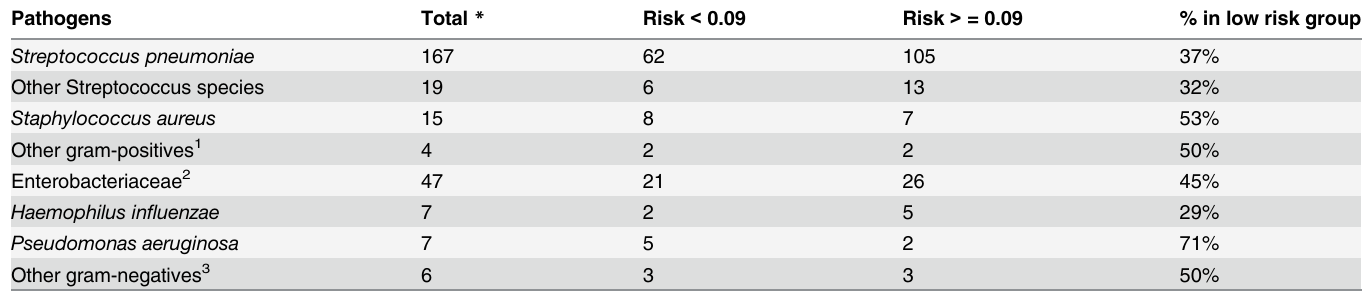
Table 2. pathogens isolated from blood cultures and numbers classified as low or high risk by the model without laboratory results (using 60% sensitivity target).